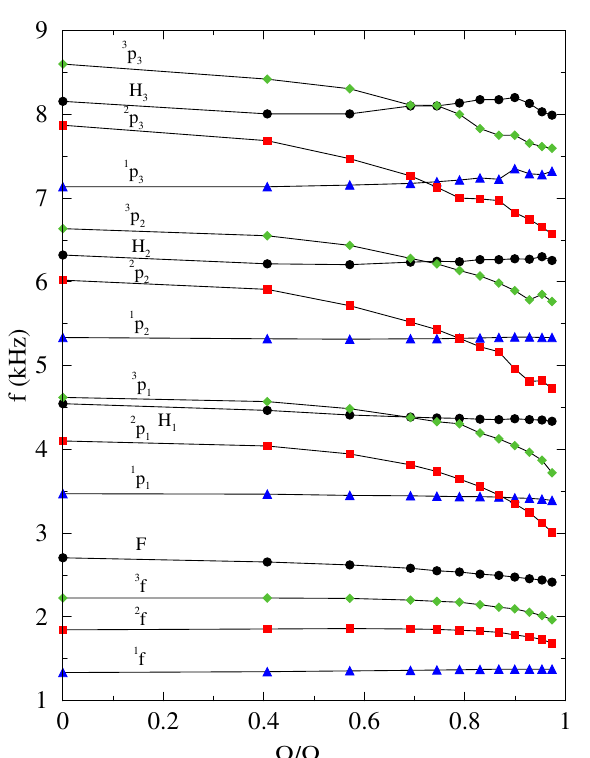
Fig. 11 Frequencies of several axisymmetric modes along a sequence of rapidly rotating relativistic poly- tropesof N = 1 . 0,intheCowlingapproximation.Onthehorizontalaxis,theangularvelocityofeachmodel is scaled to the angular velocity of the model at the mass-shedding limit. Lower order modes are weakly affected by rapid rotation, while higher order modes show apparent mode intersections. (Image reproduced with permission from Font et al. 2001, copyright by